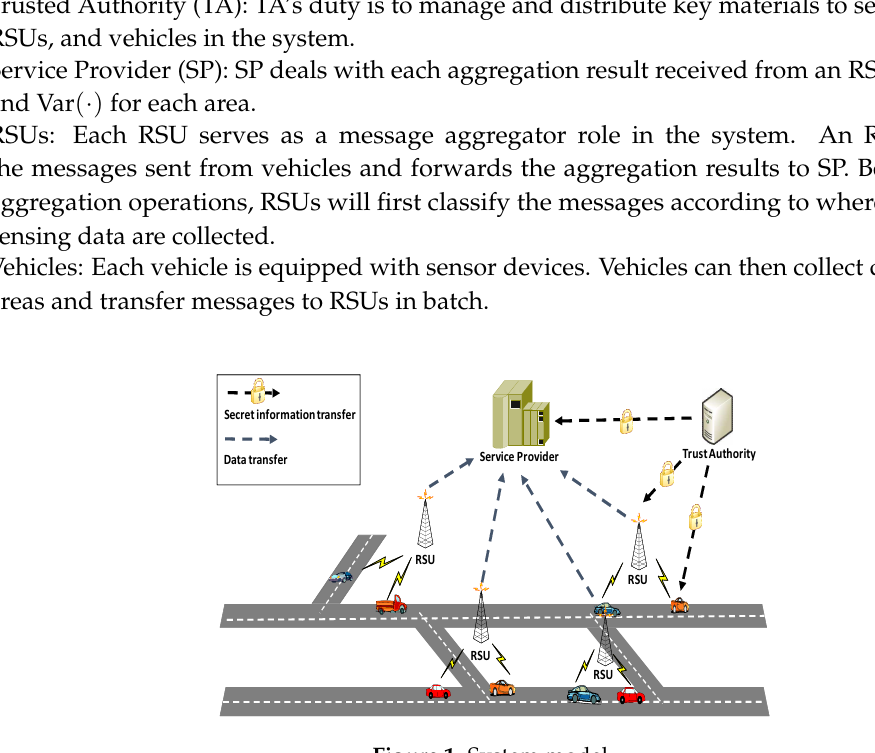
Figure 1. System